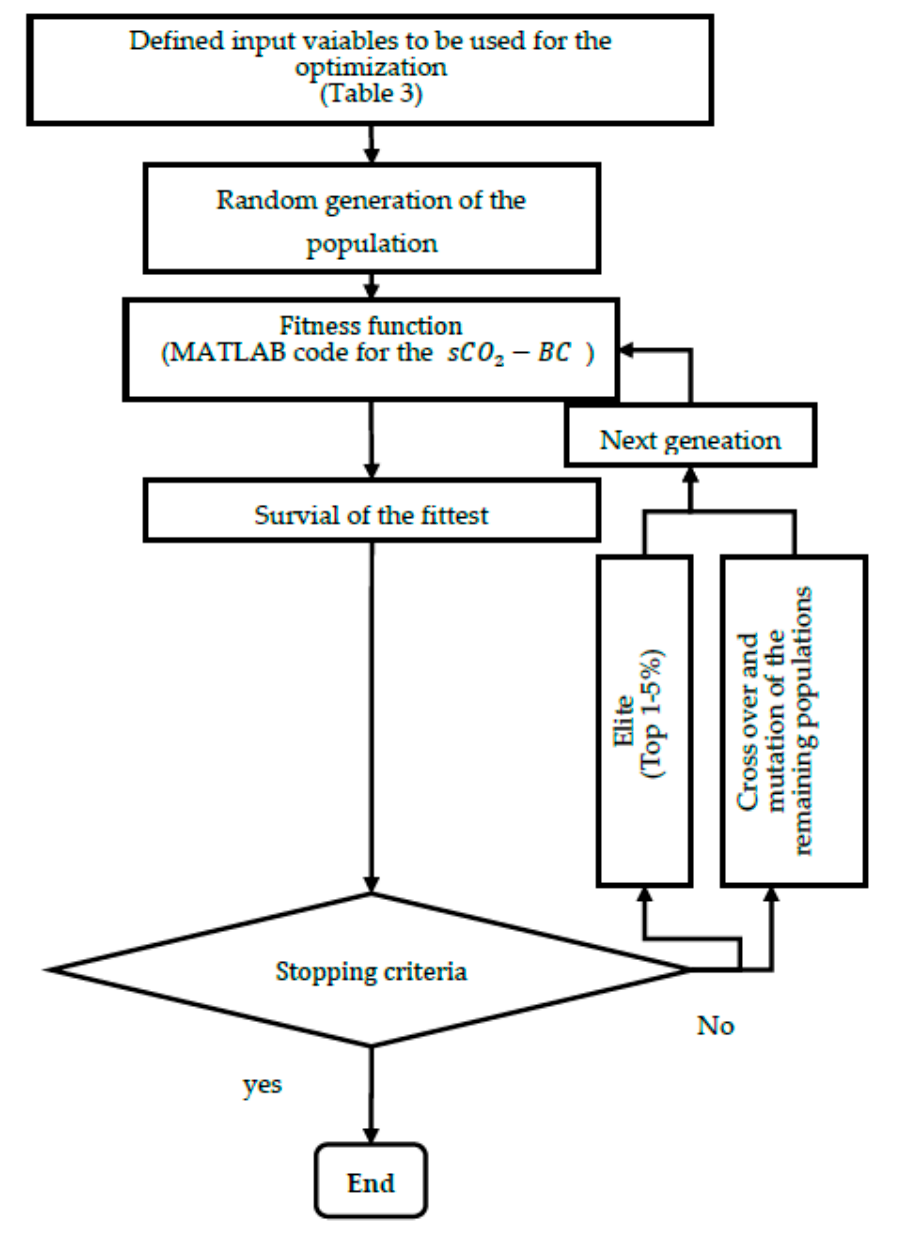
Figure 3. Schematic genetic algorithm.